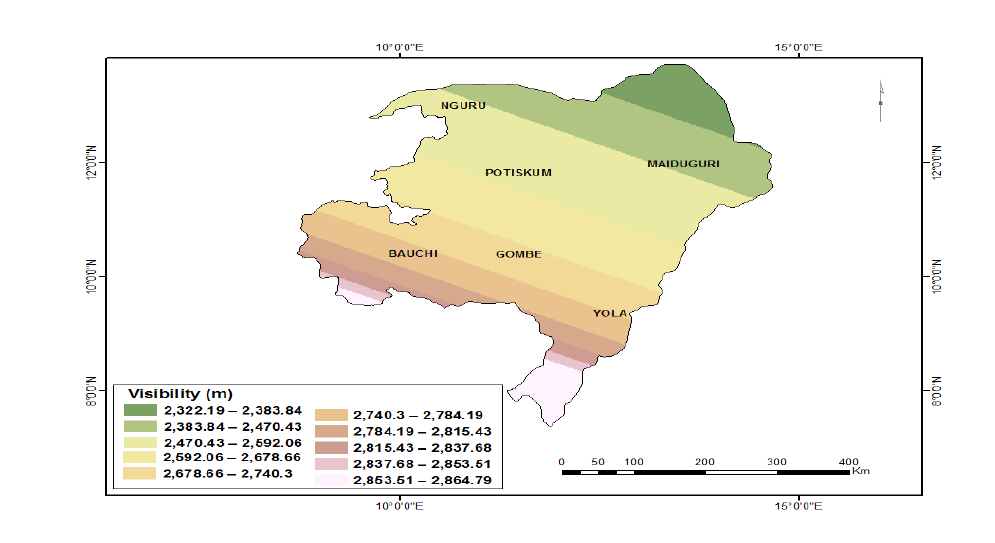
Figure 14: Spatial Air Visibility Distribution in Northeastern Nigeria (2009/2010 –